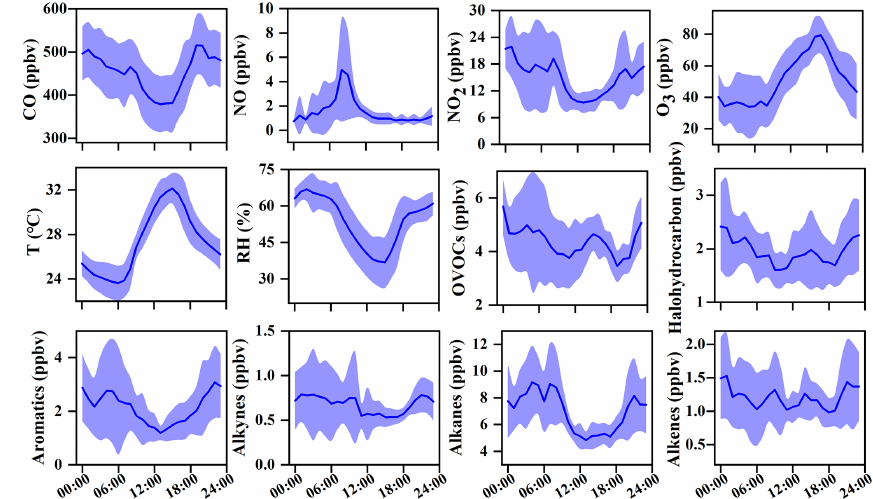
Figure 2. Average diurnal patterns of major trace gases and meteorological parameters during 20–29 September 2019 in Xiamen. The error bar is the standard error.